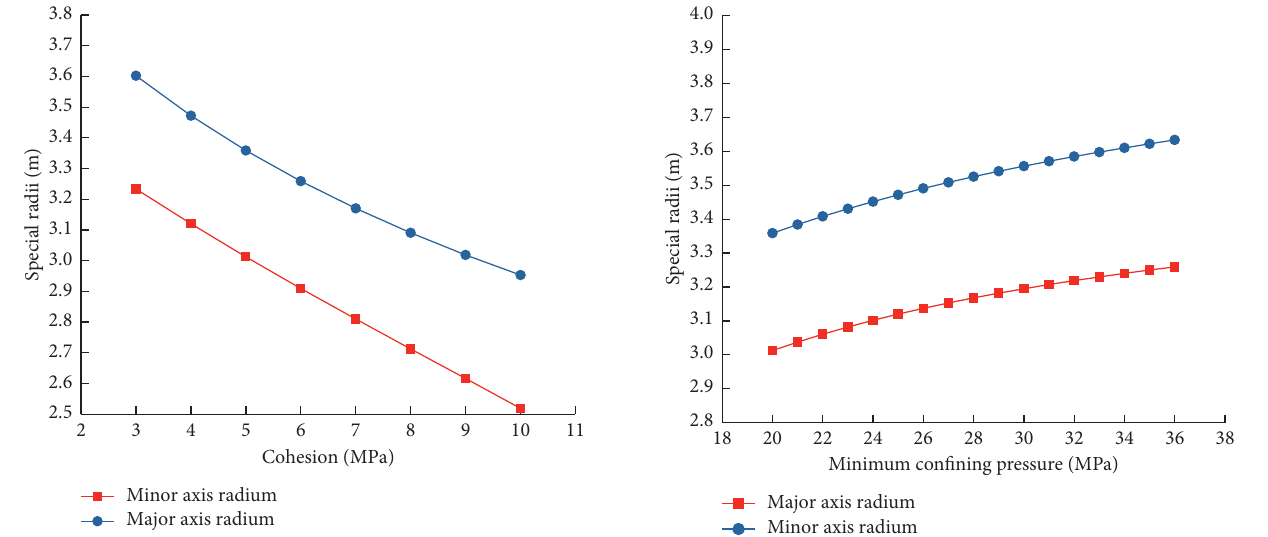
Figure 8: The relationship between special radii and cohesion.